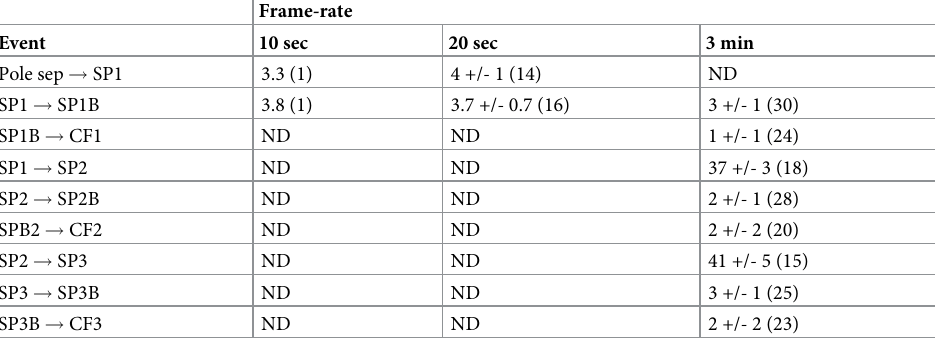
Table 1. Timing of EB1-scorable mitotic events. Time-lapse movies at varying frame-rates (top row) were analyzed manually, and mean and standard deviation of time intervals is presented (all in minutes). ‘Pole sep’: separation of the anterior EB1 signal into two separate foci. ‘SP1, SP2, SP3’: full formation of bipolar spindle in 1 st , 2 nd , 3 rd rounds of division. A spindle was scored when the EB1-NG signal was continuous across the midline of the cell, and the orienta- tion of the signal was roughly perpendicular to the following cleavage furrow. ‘SP1B, SP2B, SP3B’: spindle breakdown 1 st , 2 nd , 3 rd rounds of division. Spindle breakdown was scored when the EB1-NG signal was no longer perpendicular to the following cleavage furrow. Spindle formation and breakdown were highly synchronous in progeny within a single cell, although not all spindles were in focus in every division. To calculate the spindle duration, or SP to SPB, the frame number of the first visible spindle was subtracted from the frame number of the start of the spindle breakdown, and then multiplied by the frame frequency. In cases where a spindle was not visible in any frame it was given a value of 0 frames, but only if the preceding PS was clearly visible; in these cases, it was assumed that the spindle was likely missed because it was not present at the times the images were captured. If neither the PS nor the SP were seen, the values were not recorded. ‘CF1, CF2, CF3’: detectable cleavage furrow initiation in 1 st , 2 nd , 3 rd rounds of division (for later divisions, furrow formation in any progeny cell was counted due to image complexity). A CF was scored when a visible indent associated with a dark line in brightfield, aligned with the upcoming plane of separation of the cells. The 10-sec frame-rate movie was at 26˚C; the 20-sec and 3-min movies were at 33˚C. Entries are in minutes: mean +/- standard deviation (number of cells). ND: not determined, for the following reasons: (1) 10 and 20 sec frame-rates were only usable for the first division, as cell viability dropped from light exposure; (2) cleavage furrow formation was scored from brightfield images that were captured only at 3 min resolution. Effective detection of pole separation was difficult at 3 min resolution because it was easiest to observe when moving density could be compared between adjacent frames. Only the later phases of the PS were easily seen once the poles were separated and very bright. Therefore, this was not scored in the 3 min frame-rate movies. See Figs 6 and 7 and S3 and S4 Videos for illustrative